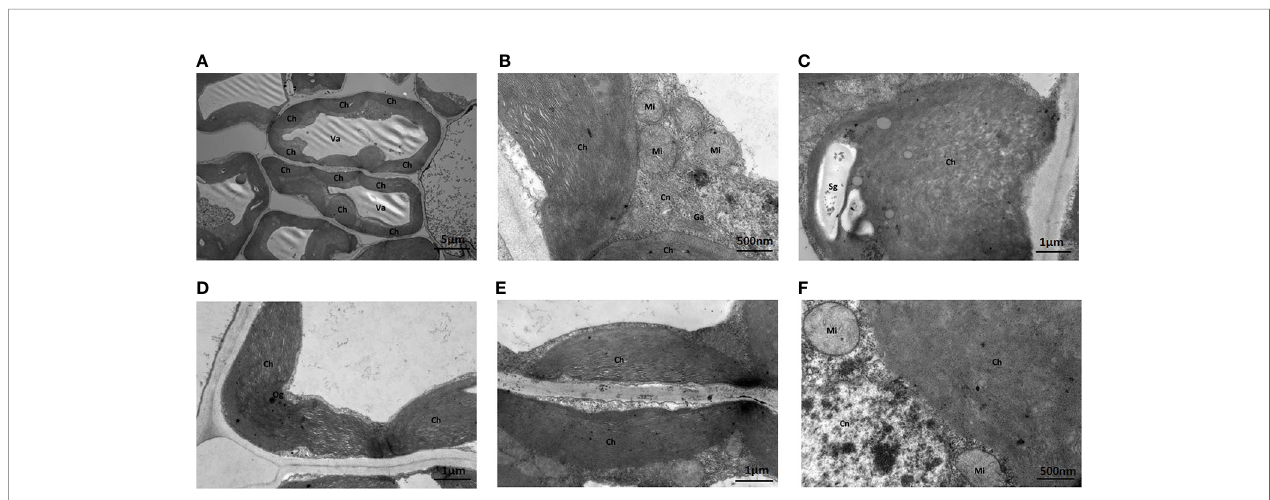
FIGURE 8 | Effect of solid MS culture medium with Na 2 MoO 4 and Na 2 WO 4 on cell morphology and ultrastructure in leaf of strawberry seedlings. (A) The whole cell with organelles of seedlings grown with Na 2 MoO 4 and Na 2 WO 4 . (B) Ch, Cn, Ga, Mi in the cell. (C) The swollen chloroplast. (D) The poorly developed chloroplast with osmiophilic granules deposited. (E) Damaged chloroplasts in the seeding cultured with inhibitor. (F) Mi, Cn, and Ch in the cell. Ch, chloroplast; Cn, cell nucleus; Er, endoplasmic reticulum; Ga, Golgi apparatus; Mi, mitochondria; Va, vacuole; Og, osmiophilic granules; Sg, starch